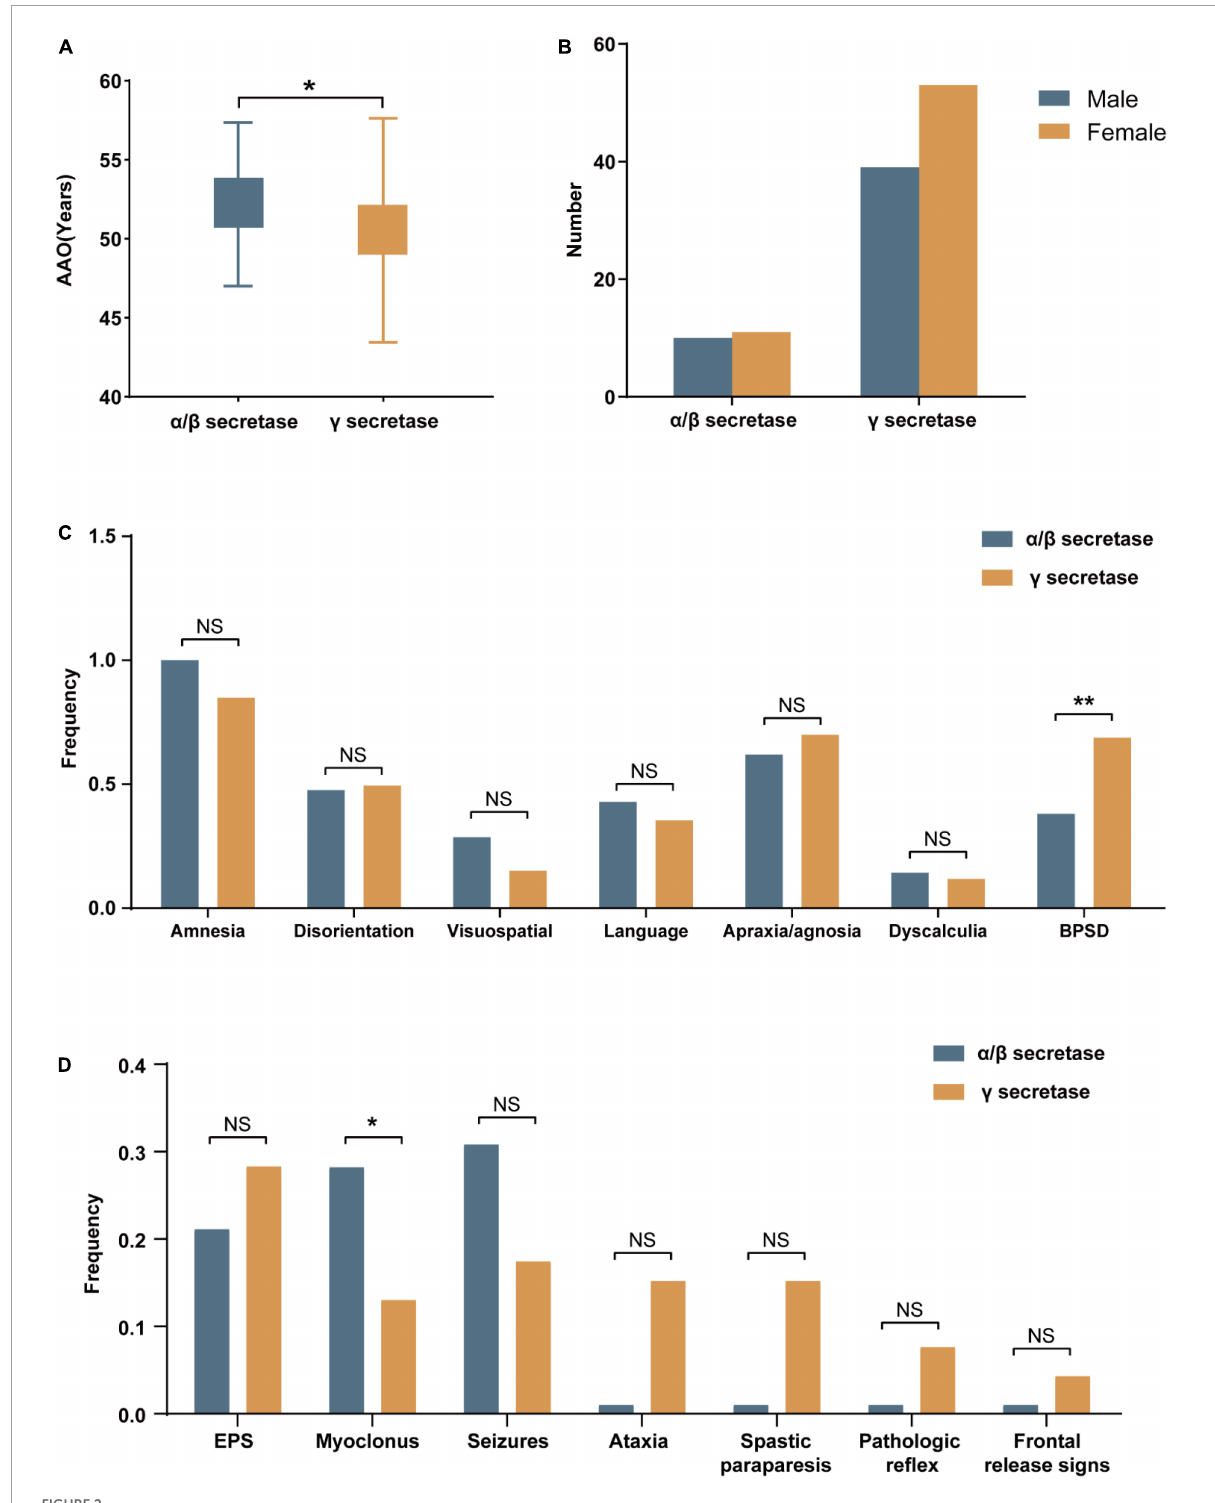
FIGURE2 The demographics and the frequencies of clinical features in mutations near α / β secretase and near γ secretase. (A) The age at onset (AAO) and (B) The gender of mutations near α / β secretase and near γ secretase. (C) The frequencies of amnesia and non-amnestic clinical phenotype. (D) The frequencies of neurological symptoms (NS, no significance, * p < 0.05, ** p <